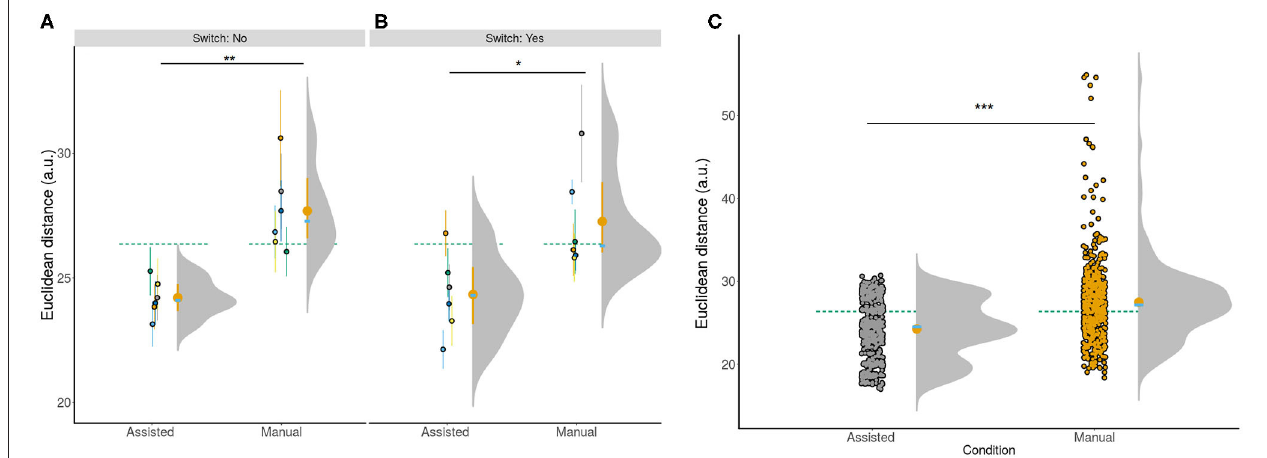
FIGURE 3 | Accuracy of individual conditions for all subjects. (A,B) show subject color-coded summarized information ( N = 6). The accompanying lines denote the 95% CI for the non-switch (A) and switch (B) condition. (C) Shows the same information collapsed across both (A,B) in addition to showing raw trial information across all subjects to show the full distribution across all trials. The green dotted line in (A–C) is the grand mean collapsed across all conditions. The yellow error bar corresponds to the condition mean and 95% CI. The superimposed blue bar shows the condition median. *** p < 0.001, ** p < 0.01, * p < 0.05. All three panels show that the assisted condition resulted in higher accuracy compared to manual control.